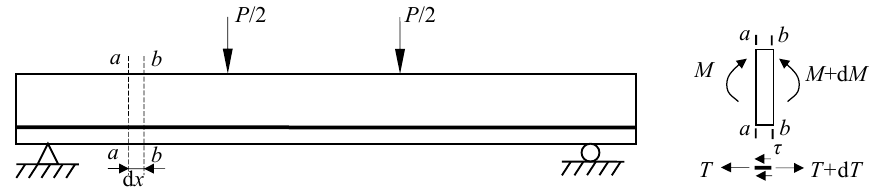
Figure 11. Failure modes of the TRC specimens with different number of textile layers.